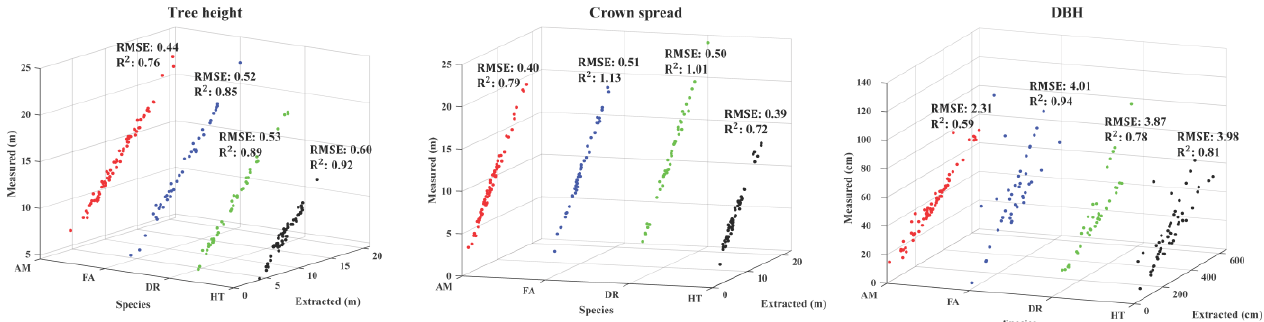
Figure 5. Comparison of tree basic parameters of four species between manual measured values and extracted values from 3D tree model. RMSE and R 2 are the root mean squared error and r-squared error of each parameter.